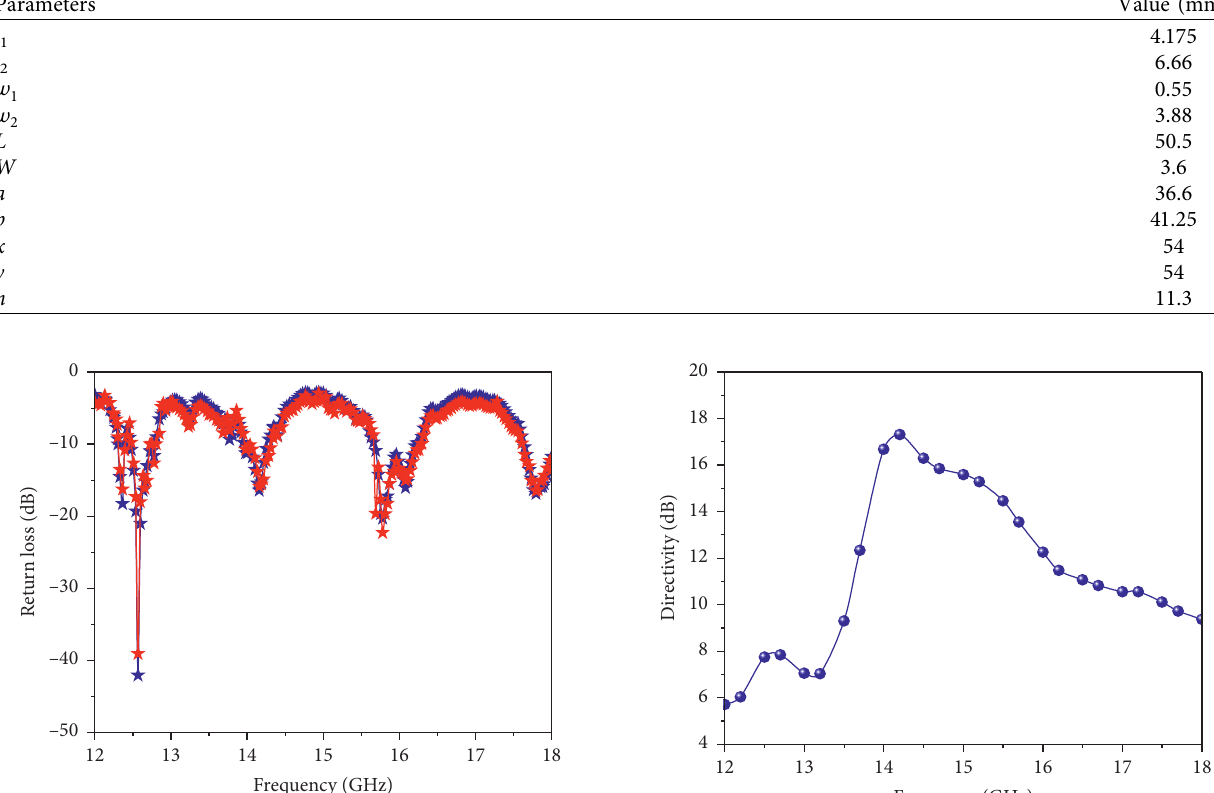
Table 1: Dimensions of the proposed antenna used in the simulation design. Parameters